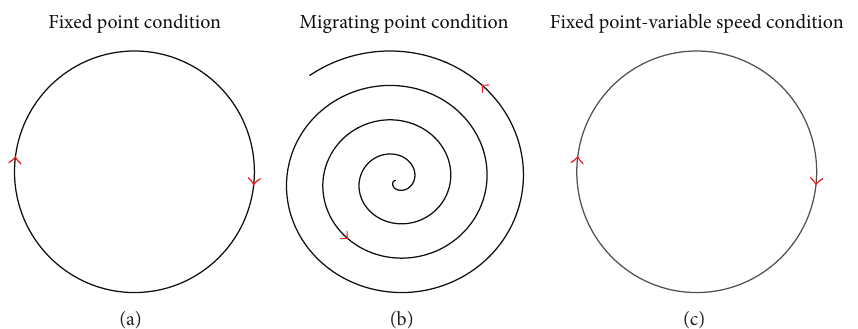
Figure 1: Different contact conditions in the ball-on-disk test. (a) fixed point condition and circular geometry, (b) migrating point condition and spiral geometry, and (c) fixed point-variable speed condition and circular